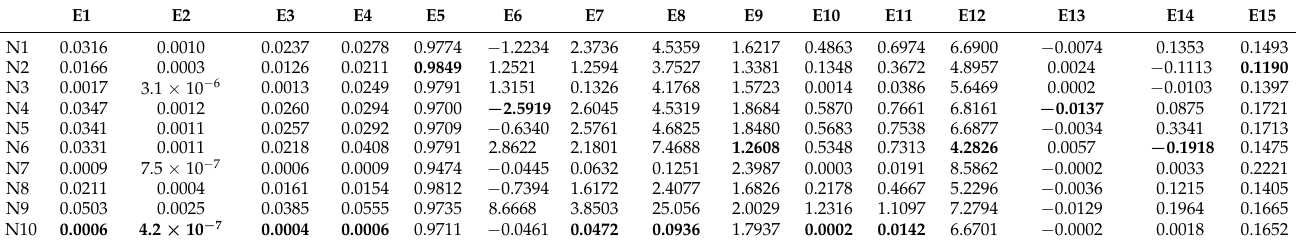
Table 8. Error values in testing Legendre network for Binance dataset.